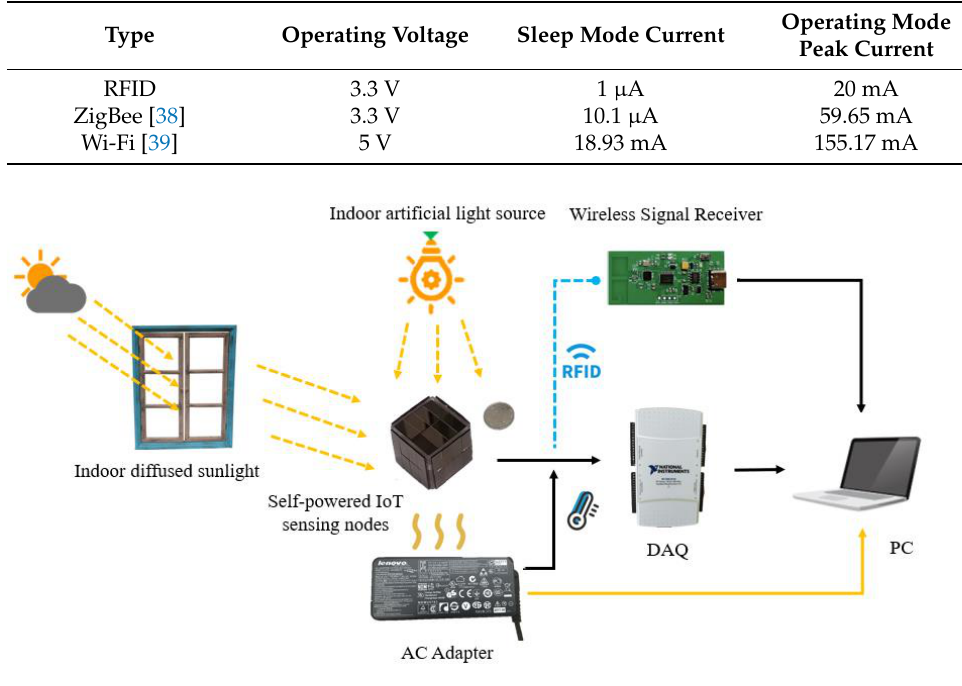
Figure 15. Application demonstration of temperature monitoring and early warning for indoor AC adapter.